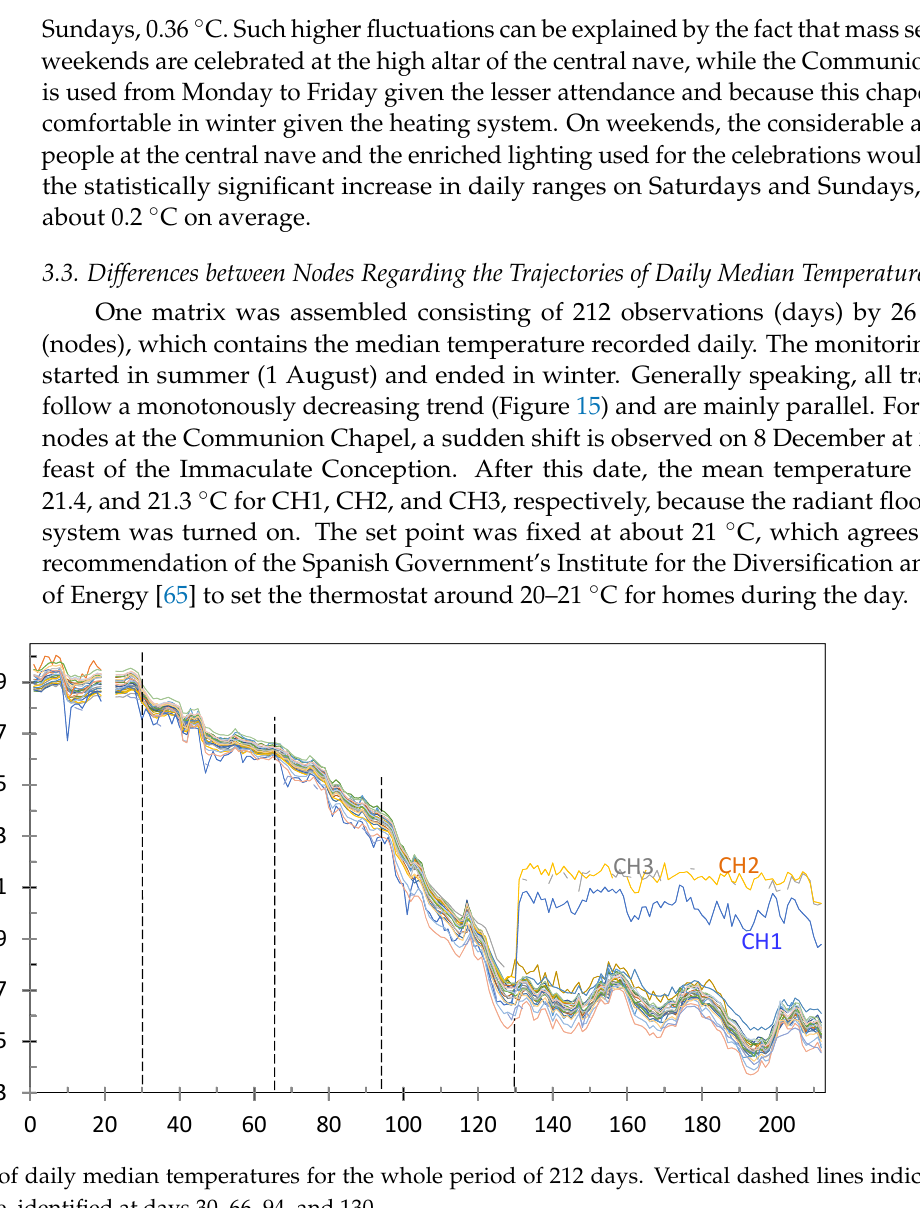
Figure 16. Results from the PCA applied to the matrix of daily medians for the period of 130 days: ( a ) evolution of scores corresponding to PC1, ( b ) evolution of scores corresponding to PC2. In order to better characterize this evolution of microclimate conditions, four sub- periods were considered based on Figures 15 and 16: days 1 − 30, 31 − 66, 67 − 94, and 95 − 130. According to Figure 15, the mean temperature is basically constant up to day 30 (summer); next, there is a progressive temperature decrease that becomes more pronounced from day 66 onwards and on day 94. Thus, an individual PCA model was performed for each stage, as discussed next.